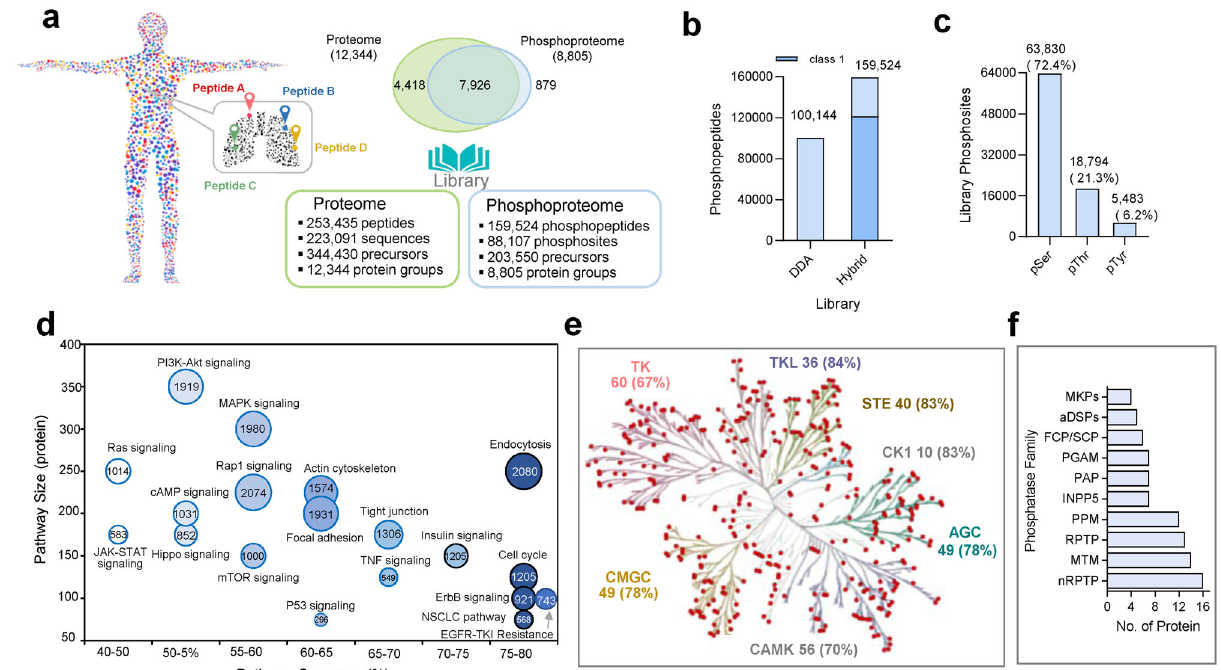
Fig. 3 Composition of the reference spectral library for the global phosphoproteome system. a Proteome and phosphoproteome libraries composition and protein groups overlap. b Phosphopeptides in hybrid and DDA-only libraries. c Distribution of phosphorylated serine (pSer), threonine (pThr), and tyrosine (pTyr) in the global phosphoproteome system (GPS) library. d Pathway annotation of phosphoproteins in the library using Kyoto Encyclopedia of Genes and Genomes (KEGG) database. The circle size corresponds to phosphosite coverage, whereas the X and Y axis shows protein coverage in the pathway and size of protein, respectively. The number in the circles shows number of phosphosites covered in the pathway. The blue color intensity shows the percentage of pathway coverage. e Kinase tree revealed 383 kinases in the library with proportion of each kinase family covered shown in bracket. KinMap database (http://www.kinhub.org/kinmap/) was used with input of protein accession number from GPS library. The kinase families listed includes TK (tyrosine kinases), TKL (tyrosine kinase-like), CK1 (casein kinase 1), CAMK (calcium/calmodulin-dependent protein kinase), AGC (containing PKA, PKG, PKC families), CMGC (containing CDKs, MAPK, GSK, CLK families), and STE (serine/threonine kinases many involved in MAPK kinases cascade). f Phosphatase obtained mapping to human dephosphorylation database (DEPOD) (www.depod.org). A total of 140 phosphatases were included in the library with the top ten families shown. The phosphatase family abbreviated are RPTPs (receptor protein tyrosine phosphatases), nRPTPs (nonreceptor- type protein tyrosine phosphatases), MKPs (MAPK phosphatases), aDSPs (Atypical DSPs), MTM (Myotubularins), PPM (protein phosphatase Mg2 + or Mn2 + dependent), FCP/SCP (TFIIF-associating component of RNA polymerase II CTD phosphatase/small CTD phosphatase), PAP (Phosphatidic acid phosphatase), INPP5 (Inositol-1,4,5-trisphosphate 5-phosphatase), and PGAM (Phosphoglycerate mutase). Source data are provided as a Source Data fi